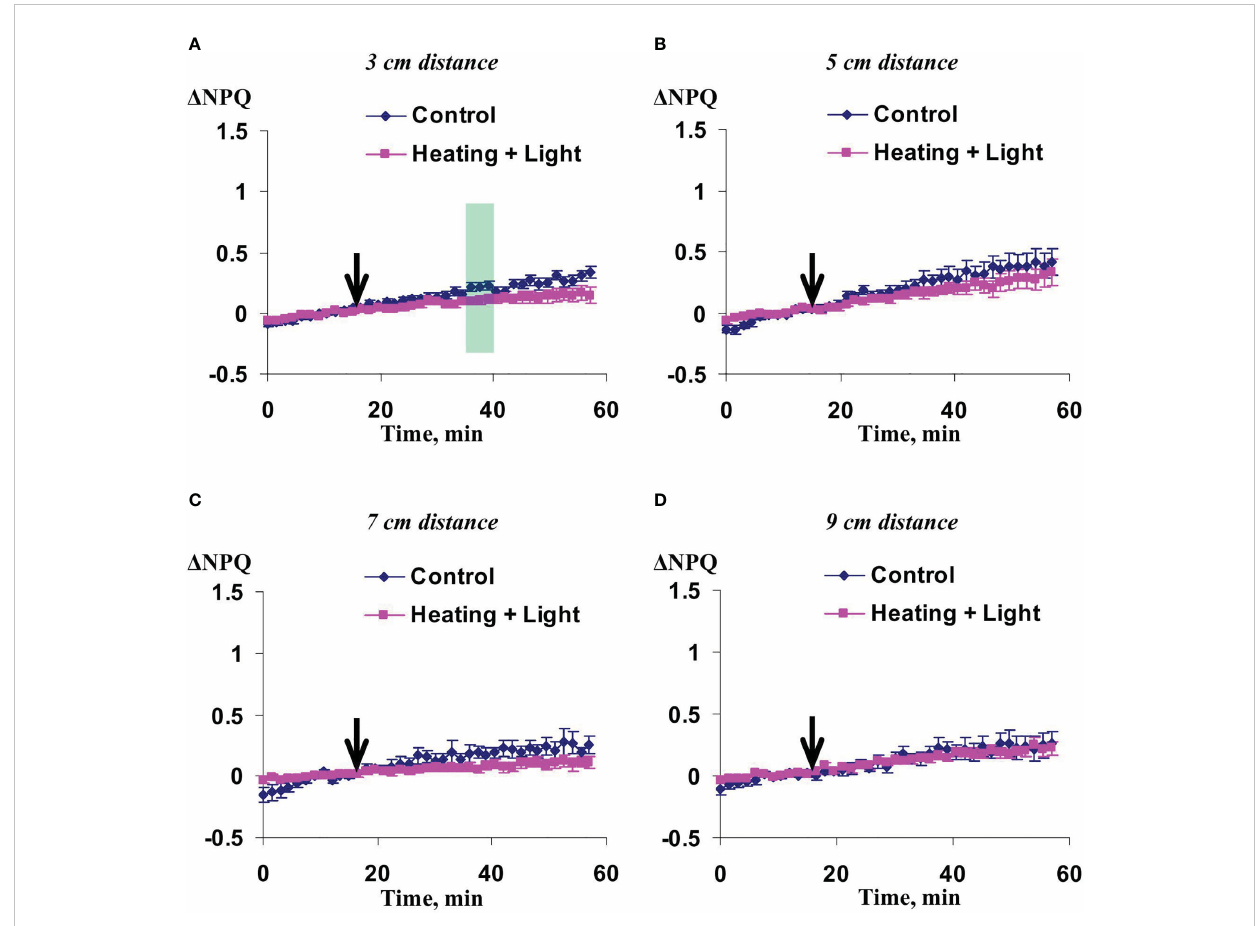
FIGURE 9 Averaged changes in the non-photochemical quenching of chlorophyll ( D NPQ) in 3 cm (A) , 5 cm (B) , 7 cm (C) , and 9 cm (D) from zone of the local action of combination of heating and blue light in wheat plants after 14-day soil drought ( n =12). Arrow marks initiation of this action; control plants were not irritated. D NPQ was calculated as NPQ - NPQ 0 , where NPQ 0 was measured before the initiation of the irritation. Intensity of the white actinic light was 456 µmol m -2 s -1 . Green shading shows time interval with signi fi cant differences between experimental and control values ( p <0.05, Student ’ s